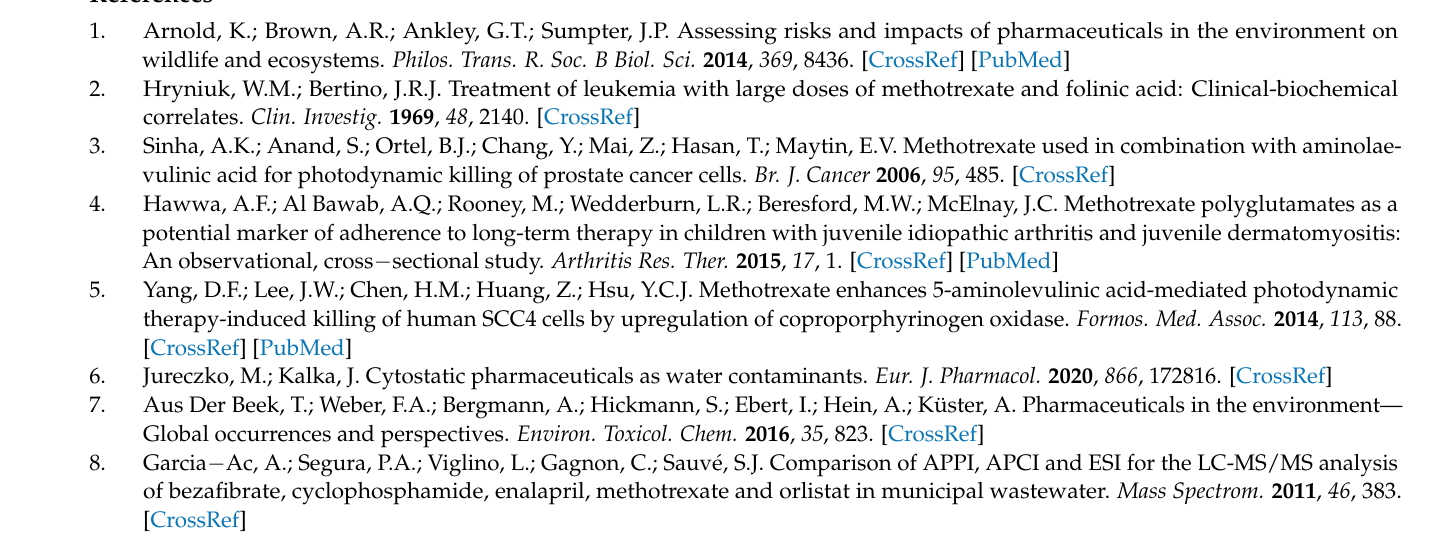
MWCNT. Figure S2. Cyclic voltammetry for (a) GCE and (b) MWCNT/GCE in the standard solution of methotrexate 100 µ mol L − 1 , υ = 50 mVs − 1 . Figure S3. Electropolymerization of 20 mmol L − 1 pyrrole, 0.1 mol L − 1 LiClO 4 , and 100 µ mol L − 1 methotrexate on the surface of MWCNT/GCE: (a) MIP/MWCNT and (b) NIP/MWCNT. Figure S4. Influence of conditioning potential prior to the electropolymerization of pyrrole. Figure S5. Conditioning parameters: (a) accumulation time and (b) applied accumulation potential. Figure S6. Cyclic voltammograms obtained from the application of (a) GCE, (b) MWCNT/GCE, (c) NIP/MWCNT/GCE, and (d) MIP/MWCNT/GCE at the following scan rates: 10, 25, 50, 75, and 100 mVs − 1 . Figure S7. Mechanism of the acid-base balance in an aqueous methotrexate solution.Table S1. Summary of detection methods for methotrexate. References [50–52] have been cited in supplementary